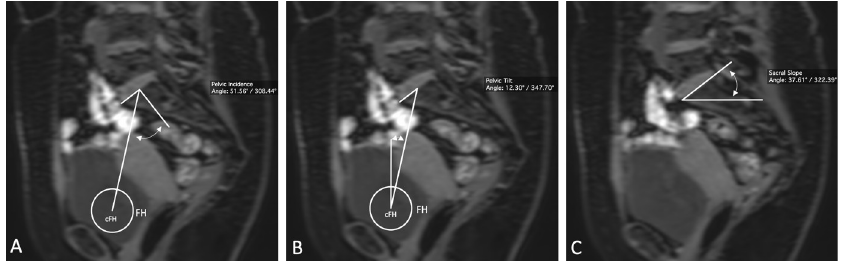
Fig 1. Measurement of pelvic incidence (A), pelvic tilt (b), sacral slope (C) and lumbar lordosis (D). Bent double arrow: Measured angle; FH: Femoral head; cFH: Center of the femoral